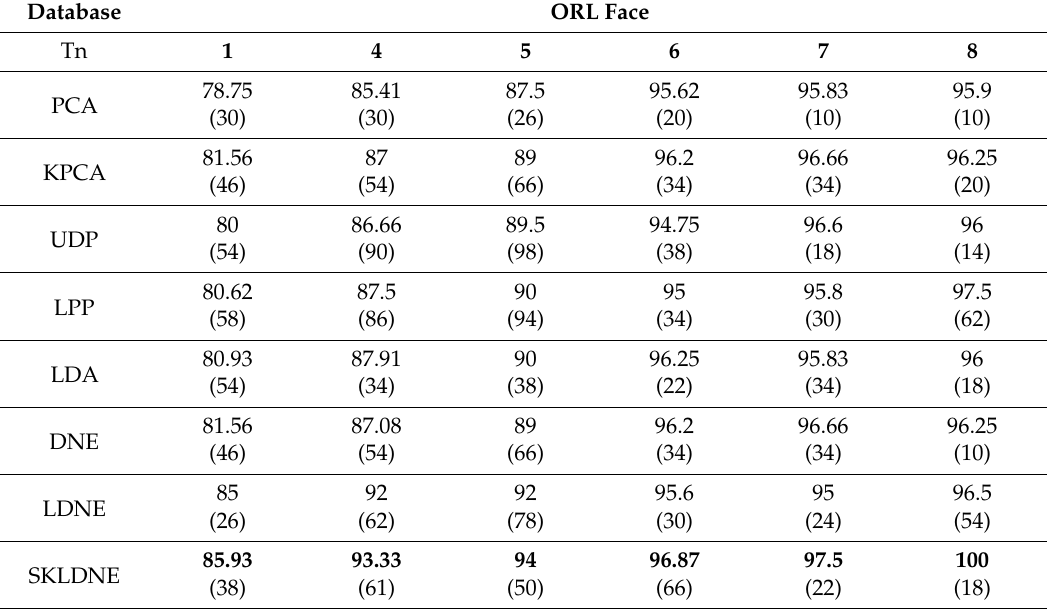
Table 3. Maximum recognition accuracies (in percentage terms) of SKLDNE and other methods for the different number of training and testing images in the ORL Face database and corresponding dimensions (shown in